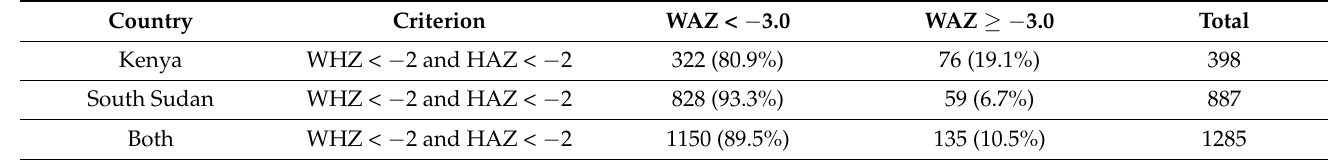
Table 3. Numbers of children at admission with a WHZ < − 2.0 and HAZ < − 2.0 identified by a WAZ < − 3.0. Country Criterion WAZ < − 3.0 WAZ ≥ − 3.0 Total Kenya